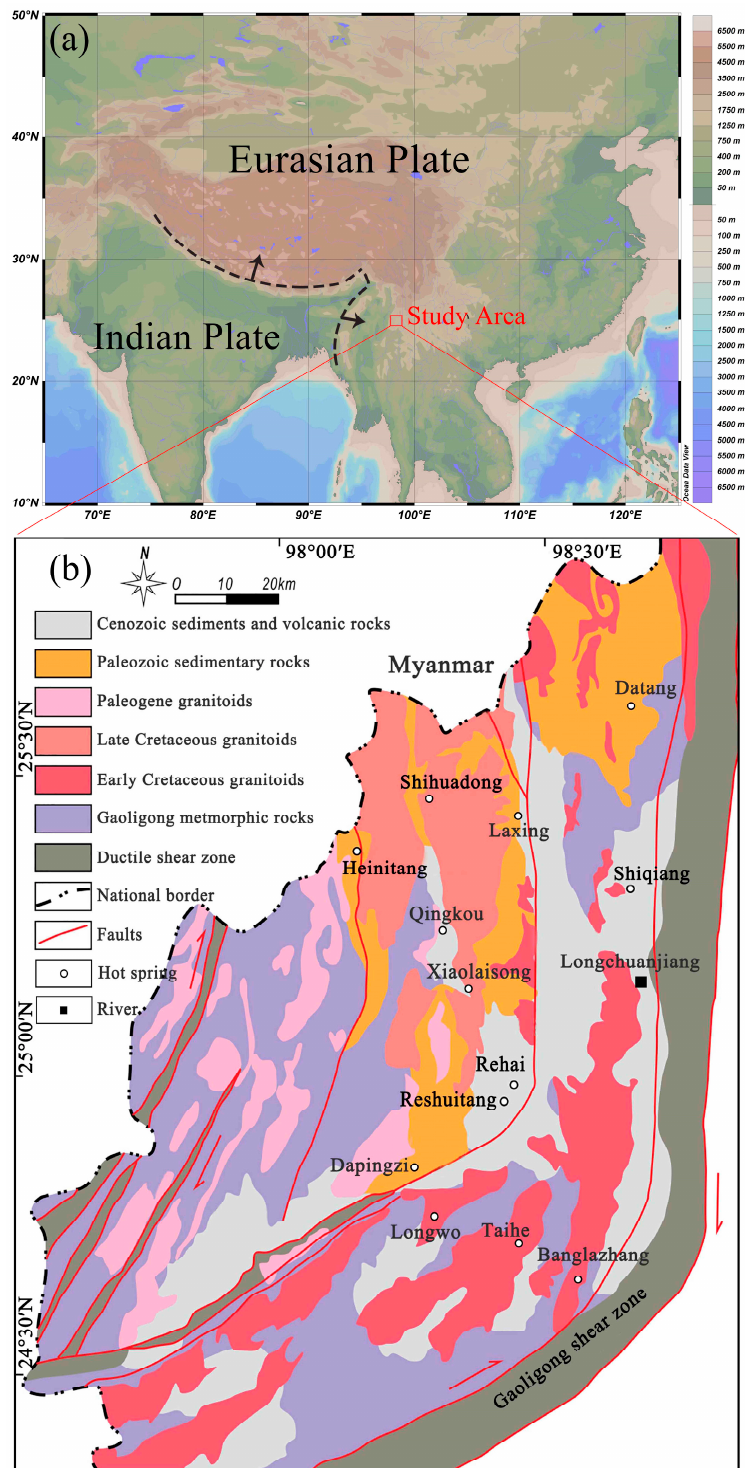
Figure 1. ( a ) The map of study area. ( b ) Distribution of the sampling sites in the Tengchong geothermal area (modified from Xie et al. [48], Shi et al. [27], and Luo et al. [49]). Reprinted with permission from ref. [27]. 2020 Shi and ref. [49]. 2021 Luo.